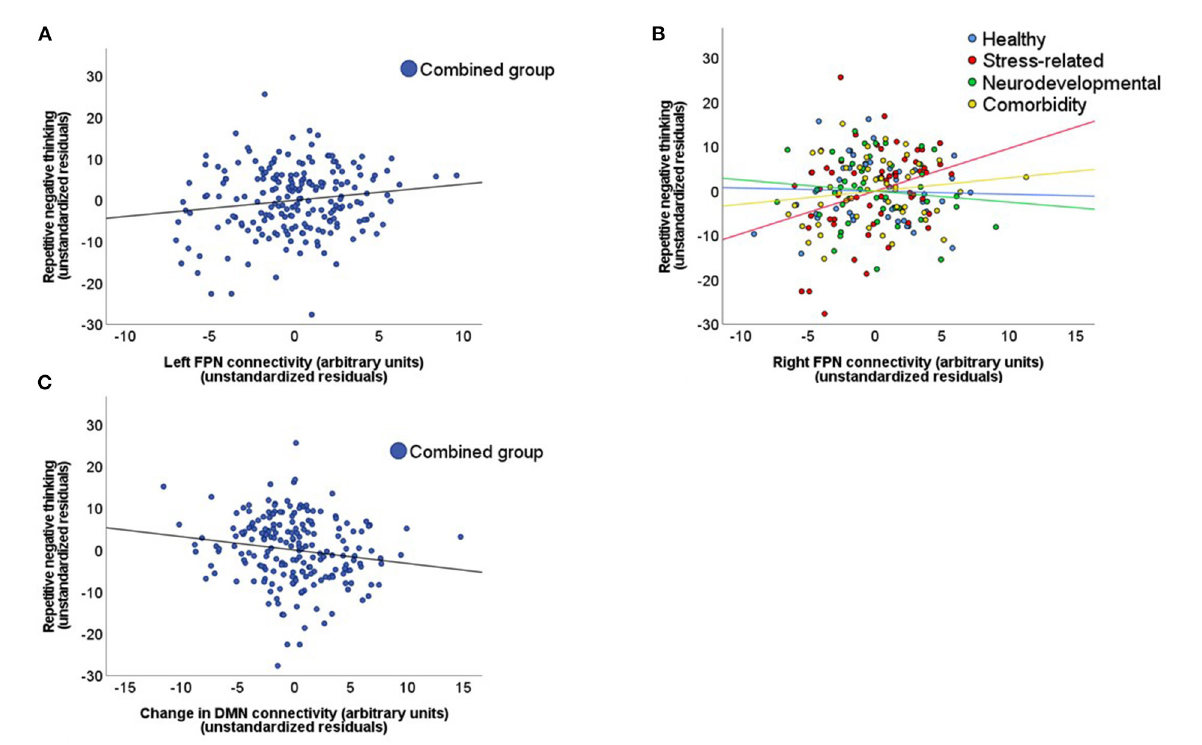
FIGURE3 Relationship between repetitive negative thinking and network connectivity strength. These scatterplots display the relationship between repetitive negative thinking (RNT), measured with the PTQ sum score, and network connectivity strength. This relationship is displayed for: (A) The left frontoparietal network (FPN) in the combined subject group during the baseline resting-state scan. (B) The right FPN for the different subject subgroups during the baseline resting-state scan. (C) The stress induced changes in default mode network (DMN) connectivity in the combined subject group (stress minus neutral